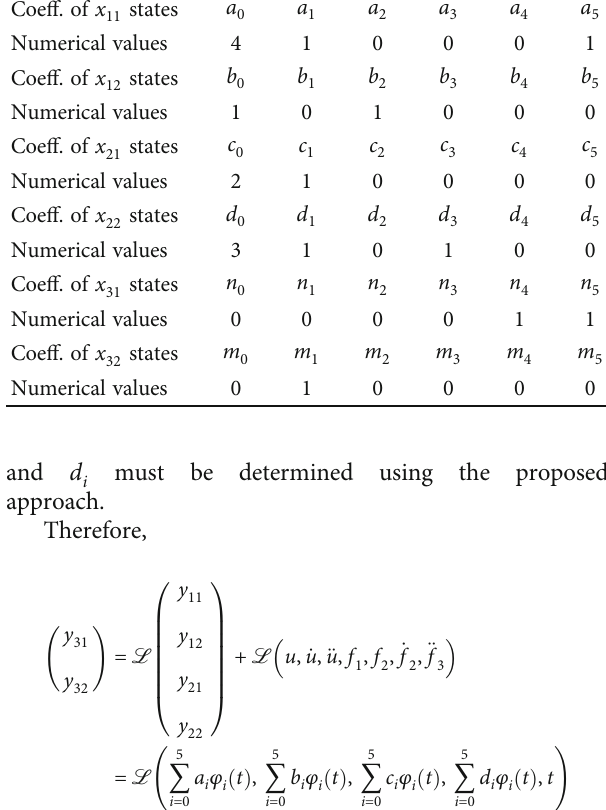
ð t Þ , x ð t 1 2